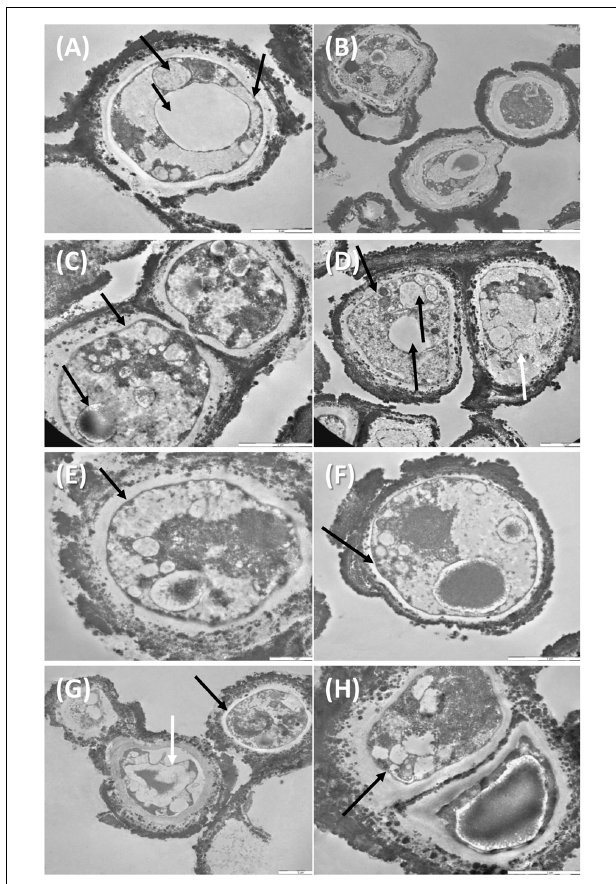
FIGURE 5 | TEM observations of C. antarcticus : Control (A , B) ; 500 Gy treatments, (C – F) cell membrane and organelles are perfectly preserved (black arrows, C–F ), damaged membrane (white arrow, D ); 1,000 Gy treatments (G , H) plasmolysis and amorphous cytoplasm (white arrow, G ) well-preserved membrane (black arrow, G,H